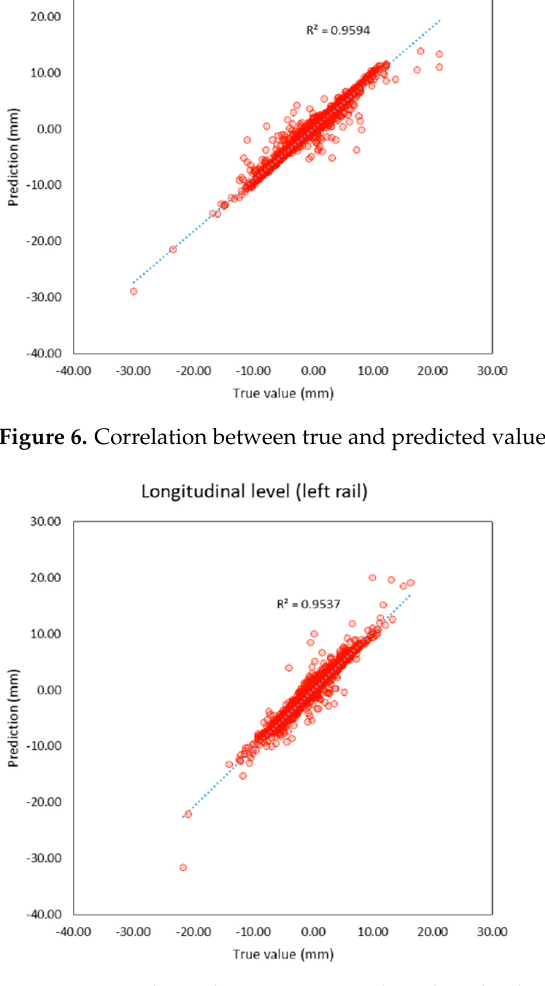
Figure 7. Correlation between true and predicted values of longitudinal level (left rail).